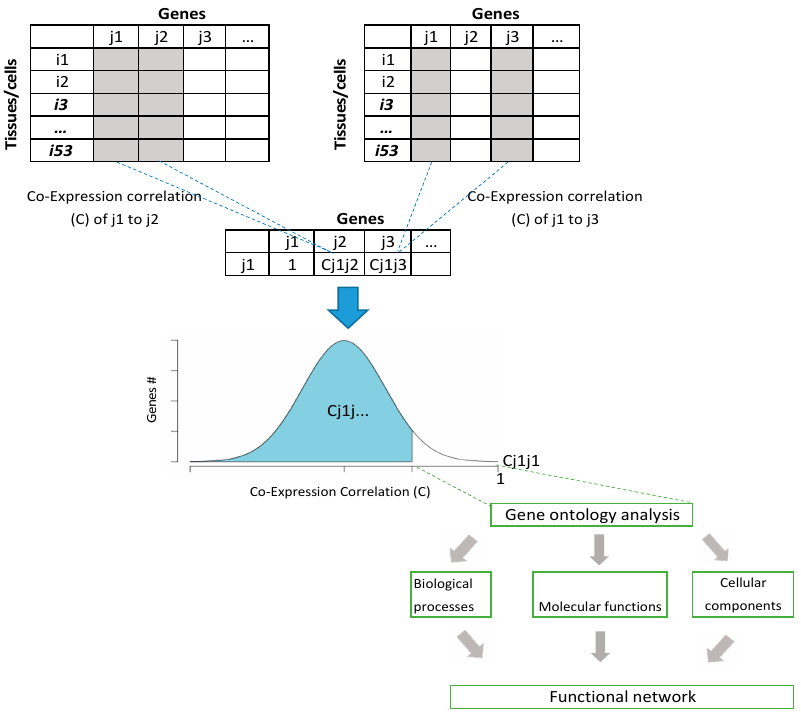
Figure 1. Co-expression correlation analysis approach. Diagram showing the process of analyzing gene functional networks using co-expression analysis. The analysis is based on any database that shows expression levels on multiple tissues and cells from the same organism.